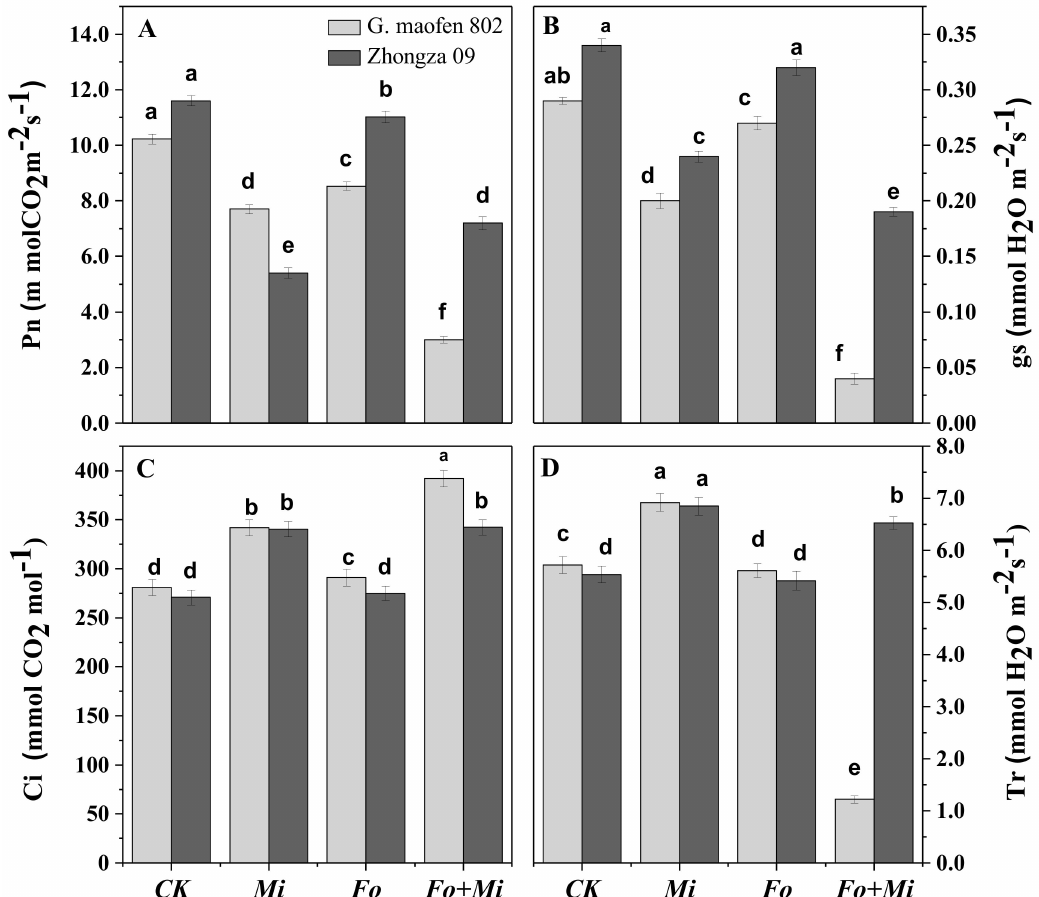
Figure 2. E ff ects of Fusarium oxysporum and Meloidogyne incognita alone and in combination on photosynthetic parameters of two tomato cultivars (G. maofen 802 and Zhongza 09) at 14 DAI in greenhouse conditions: ( A ) net photosynthesis (Pn), ( B ) stomatal conductance (gs), ( C ) intracellular carbon dioxide (Ci), and ( D ) transpiration rate (Tr). Bars showing dissimilar lower-case letters are statistically di ff erent from each other at p ≤ 0.05 (Tukey–Kramer test). Values are mean ±